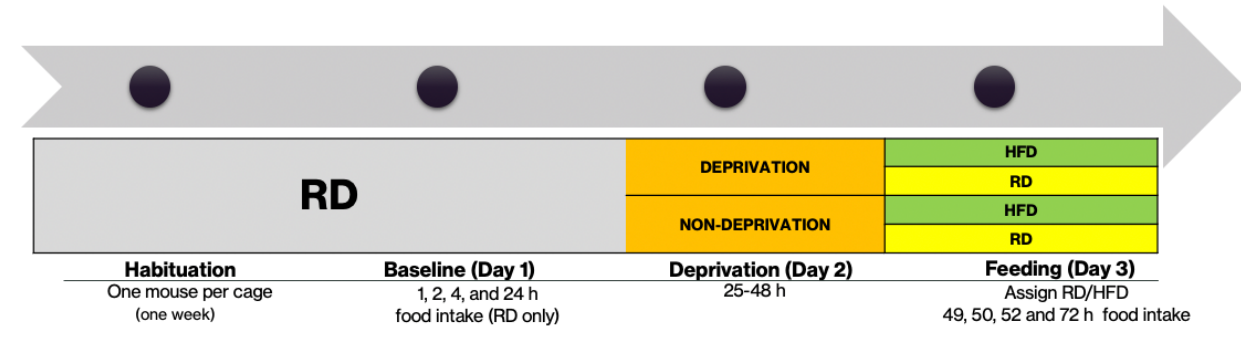
Figure 1. Schematic diagram of the food deprivation